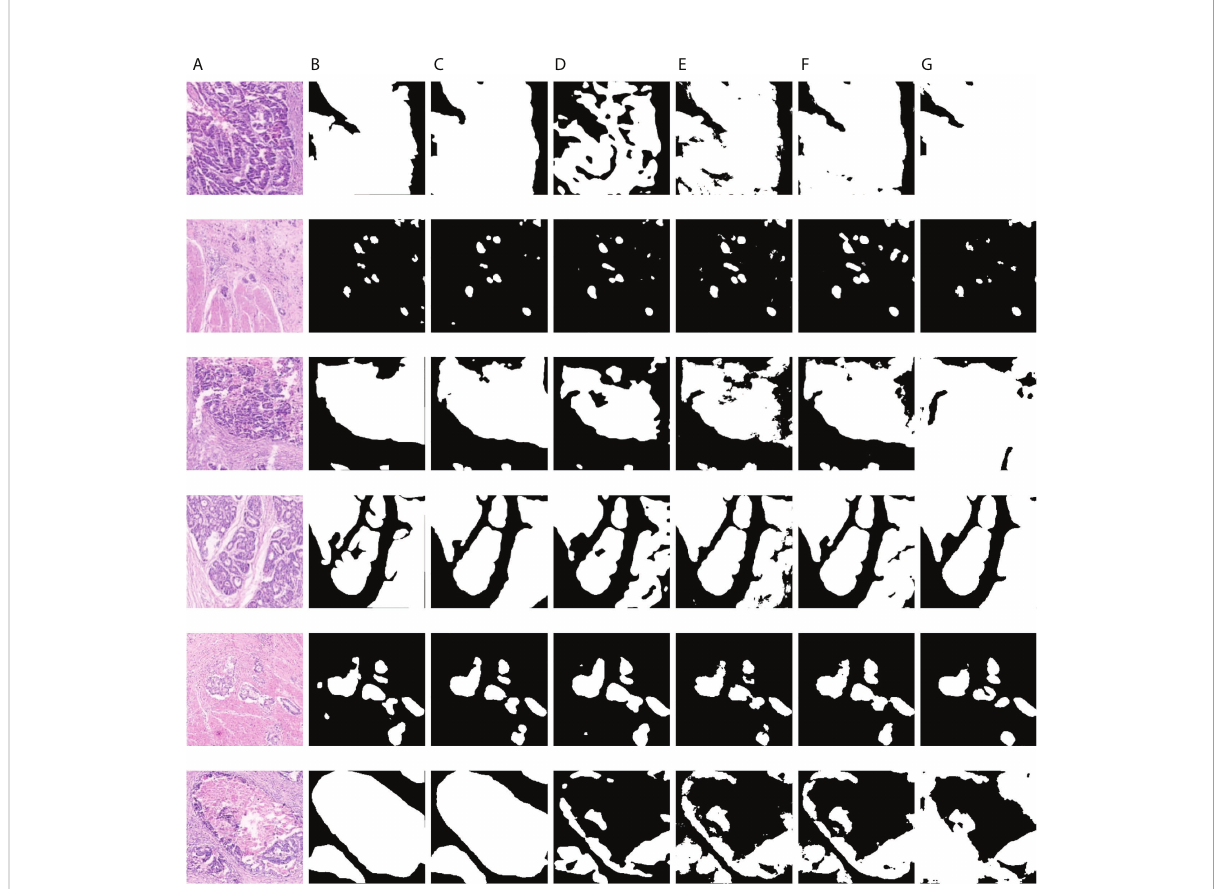
FIGURE 9 Visualization of the results of gastric cancer detection on the BOT dataset. (A) Image; (B) mask; (C) GCLDNet; (D) PSPNet; (E) LinkNet; (F) U-Net; (G) UNet3+.